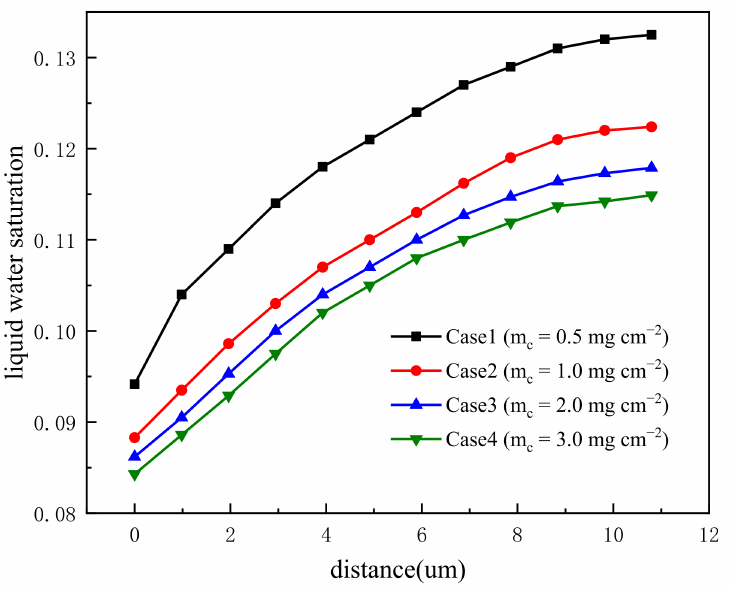
Figure 8. Effect of carbon loading on liquid water